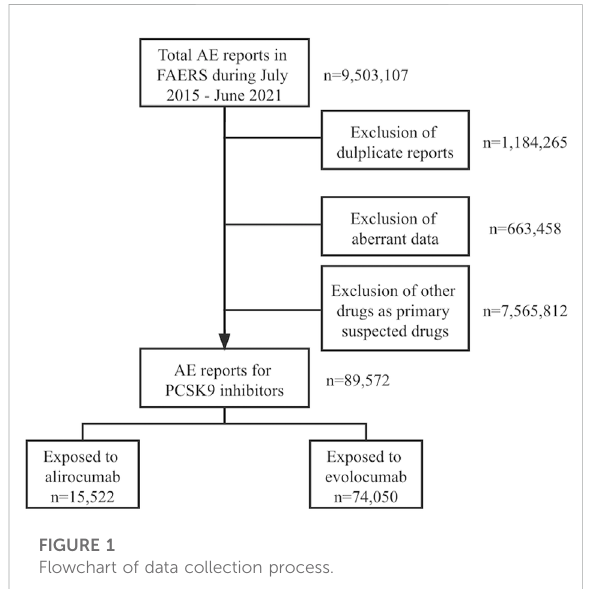
FIGURE 1 Flowchart of data collection